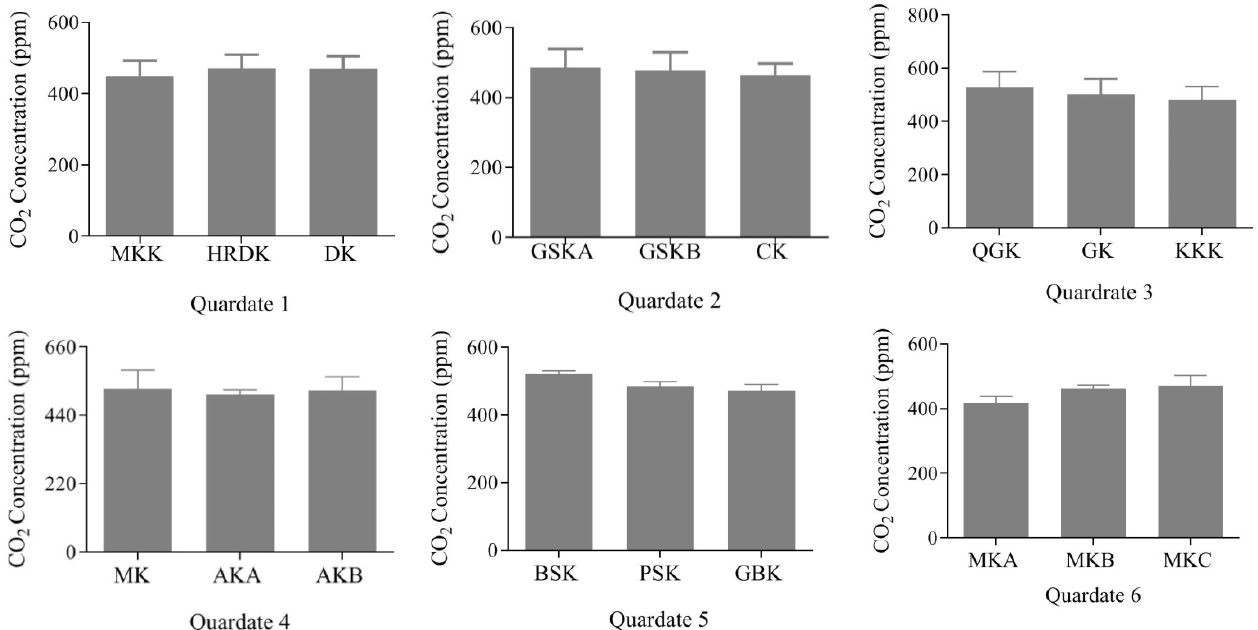
Figure 3. The concentration of CO 2 in the sampling sites.